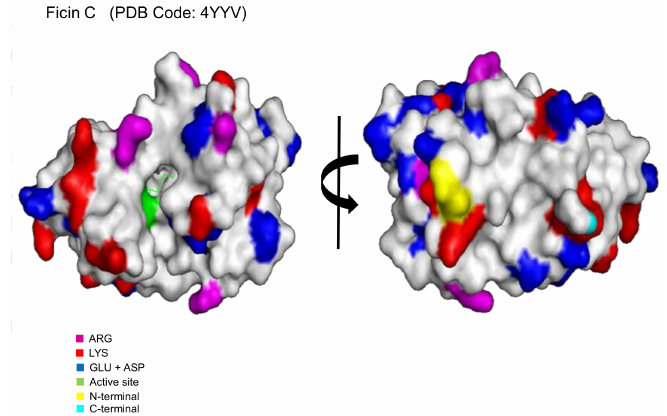
Figure 4. 3D surface structure model of Ficin C obtained from the PDB and displayed using PyMol versus 0.99. Arg, Lys, Glu+Asp, -NH 2 terminal and -COOH terminal residues are indicated.